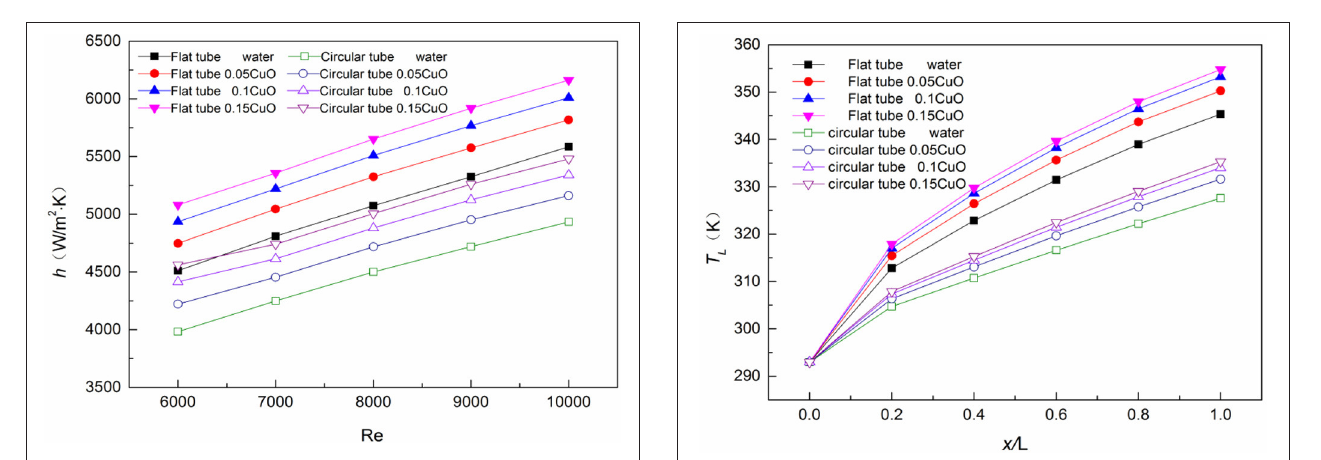
FIGURE 8 | Temperature comparison of two tubes along axial section.